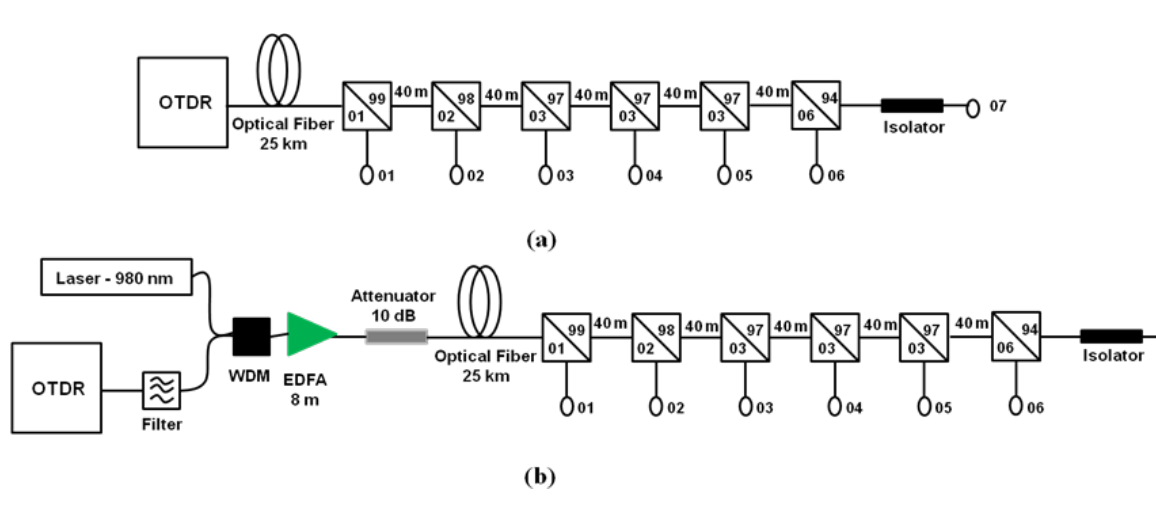
Figure 3. Multipoint corrosion sensor system ( a ) without and ( b ) with amplification (booster EDFA).